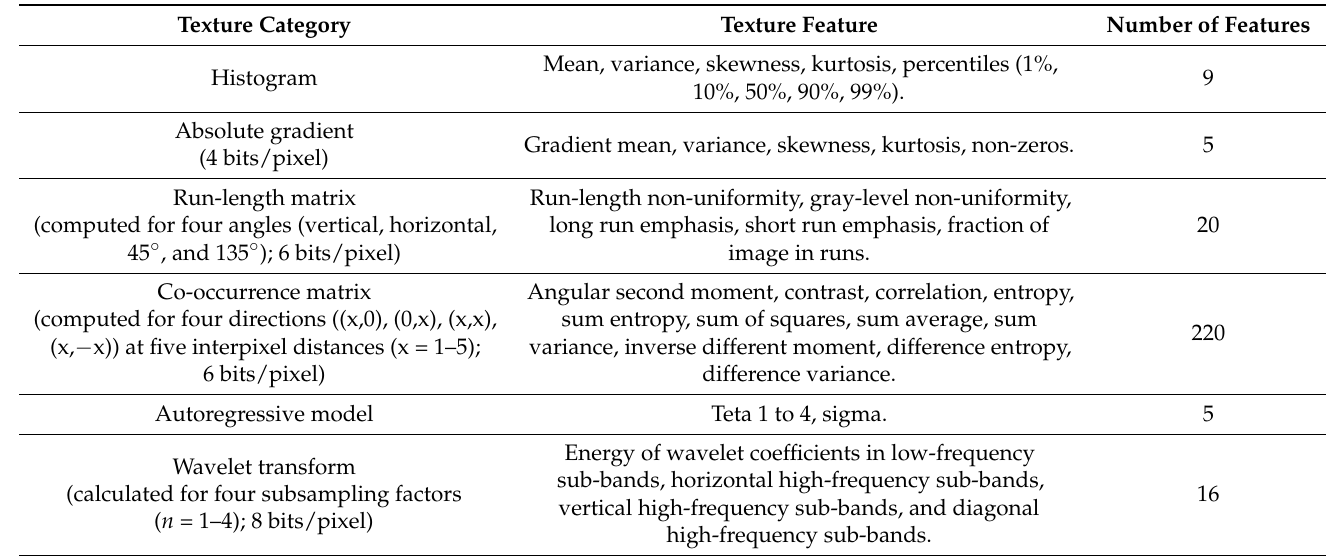
Table 2. Extracted texture categories with corresponding texture